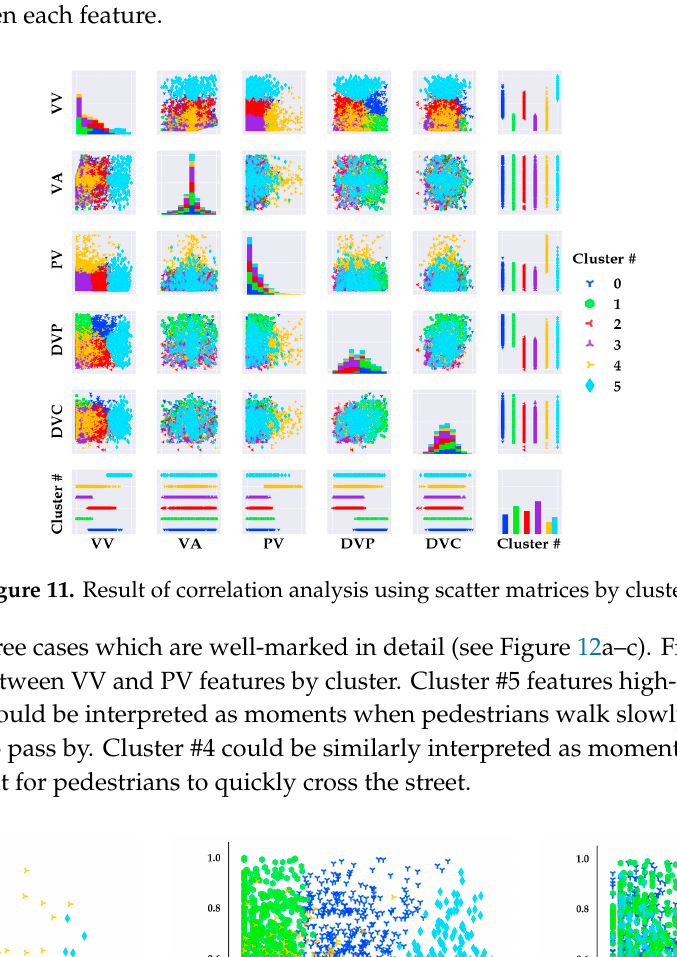
Figure 11. Result of correlation analysis using scatter matrices by clusters.